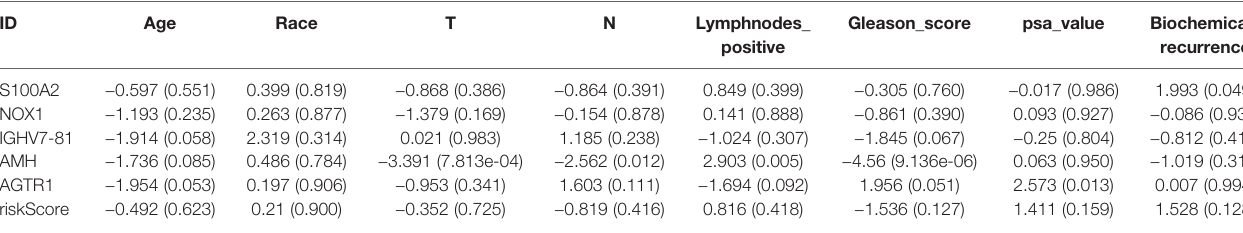
TABLE 5 | Clinical correlation analysis between these fi ve prognostic IRGs, our established risk score, and clinical